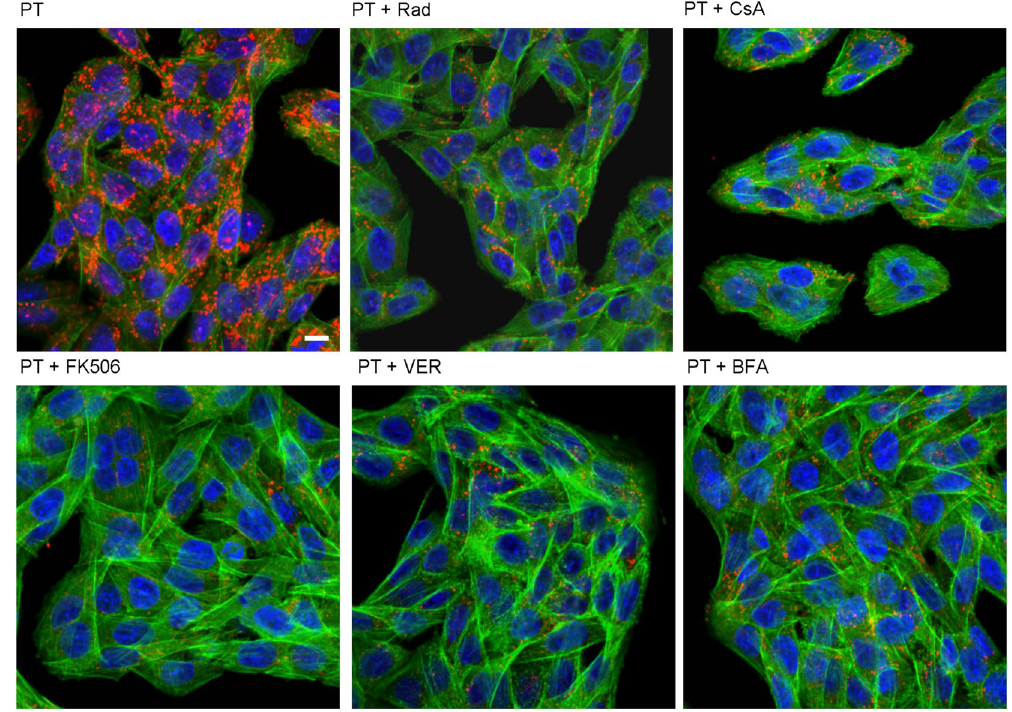
Figure 3. In the presence of inhibitors of Hsp90/Hsp70 and PPIases less free PTS1 is detected in CHO-K1 cells. CHO-K1 cells were pre-incubated with CsA, FK506, Rad (20 µM) or VER (30 µM) for 30 min. 20 µM BFA were used as control. Then, cells were challenged with 1 µg/ml PT and 1 h later medium was exchanged. After 24 h, cells were fixed, permeabilized and blocked. Subsequently, cells were probed with an anti-PTS1 antibody, Hoechst and phalloidin-FITC for F-actin staining. Pictures were taken with a Zeiss LSM-710 confocal microscope. Red = PTS1, green = F-actin, blue = nucleus, scale bar = 10